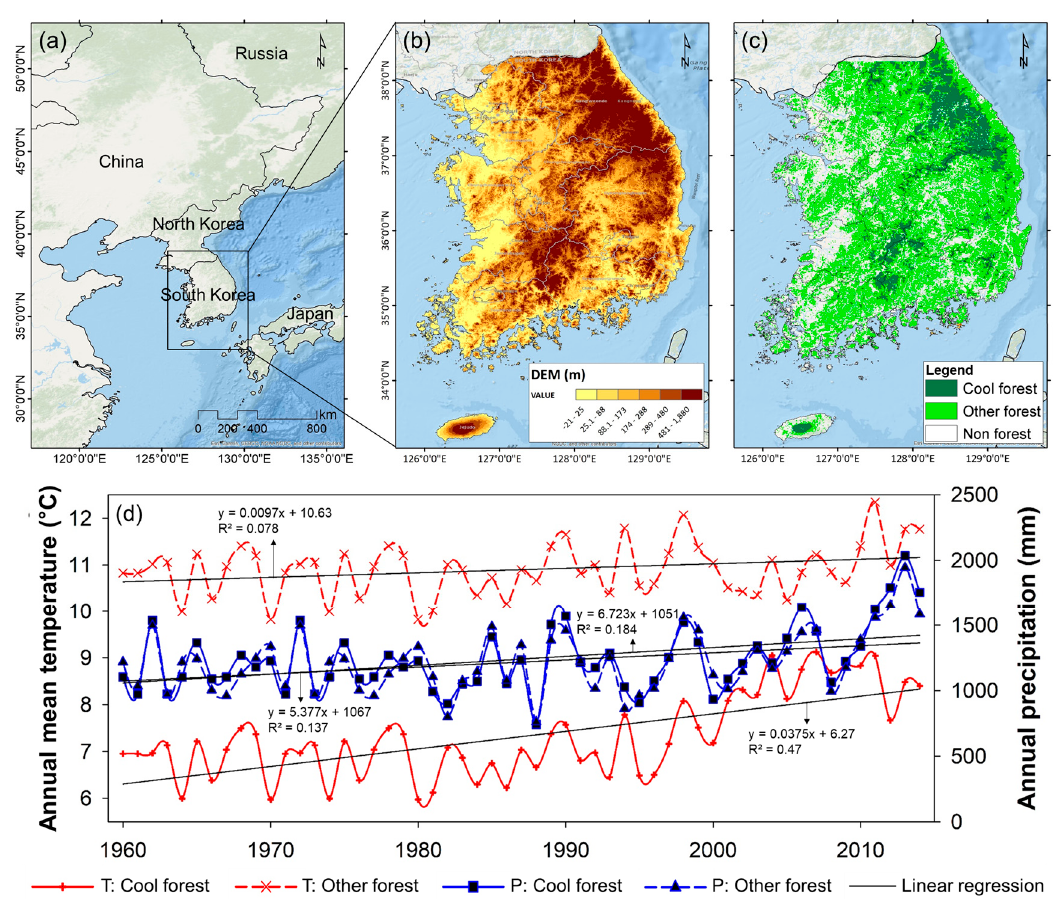
Figure 1. ( a ) Study area and its ( b ) elevation map and ( c ) forest area map. ( d ) Annual mean temperature (left) and annual precipitation (right) for South Korean forests. Cool forests were defined as forests at elevations above 700 m in the temperate zone based on the 2018 International Boreal Forest Research Association (IBFRA) Conference. T: annual mean temperature, P: annual